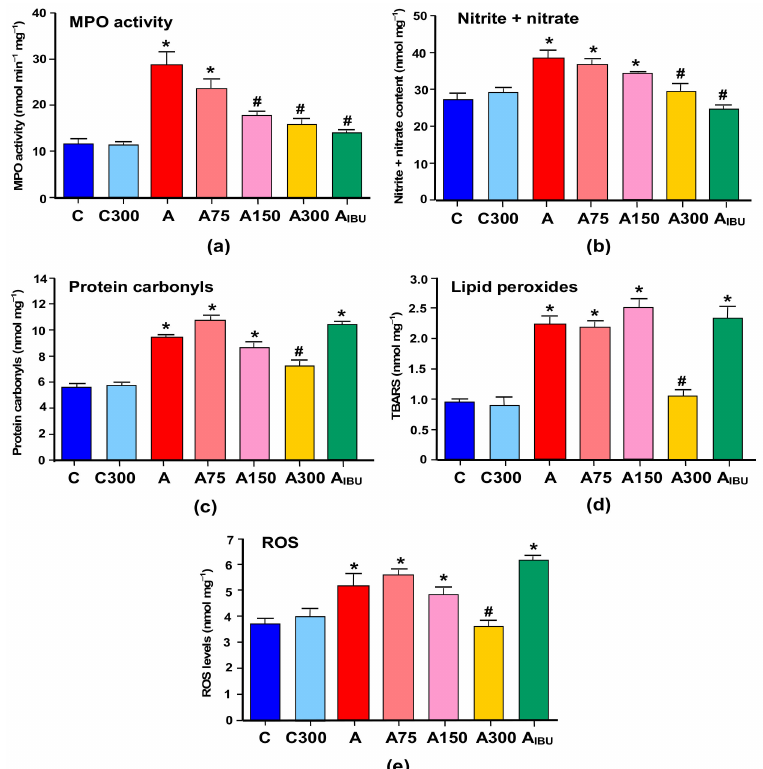
Figure 1. Effects of the methyl jasmonate (MeJA) treatment on parameters of inflammation and oxidative stress in the brain. The activity of ( a ) myeloperoxidase (MPO); and ( b ) the levels of nitrite plus nitrate; ( c ) protein carbonyl groups; ( d ) thiobarbituric acid reactive substances (TBARS); and ( e ) reactive oxygen species (ROS) were measured as described in Materials and Methods. C, controls treated with corn oil; C300, controls treated with 300 mg / kg MeJA; A, arthritic rats treated with corn oil; A75, A150 and A300, arthritic rats treated with 75, 150 and 300 mg / kg MeJA, respectively; A IBU , arthritic rats treated with 30 mg / kg ibuprofen. Data are the means ± standard errors of the mean of five animals for each experimental condition. Statistical analysis: ANOVA one-way with Newman–Keuls post-hoc testing. * p < 0.05, different from the controls (C); # p < 0.05, different from non-treated arthritic rats